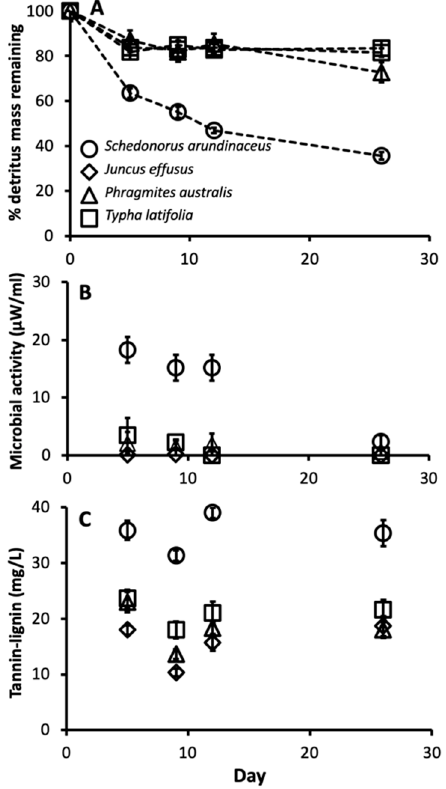
Figure 4. Mean microbial activity ( A ), % detritus mass remaining ( B ), and tannin-lignin concentration ( C ) over time for cups provisioned with each detritus species. Error bars are ± SEM.